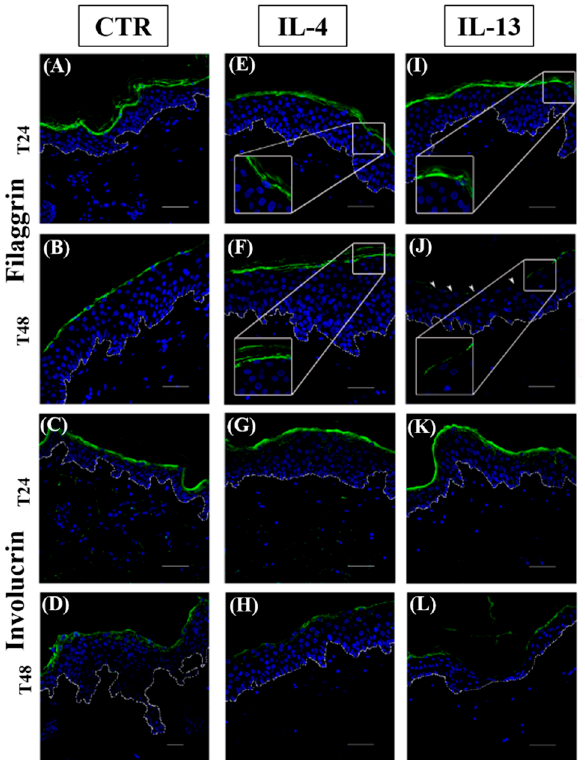
Figure 8. Immunofluorescence analysis of filaggrin and involucrin. Representative filaggrin ( A , B , E , F , I , J ) and involucrin ( C , D , G , H , K , L ) immunostainings in normal human skin paraffin sec- tions. ( A , C , E , G , I , K ): samples harvested at 24 h; ( B , D , F , H , J , L ): samples harvested at 48 h. ( A – D